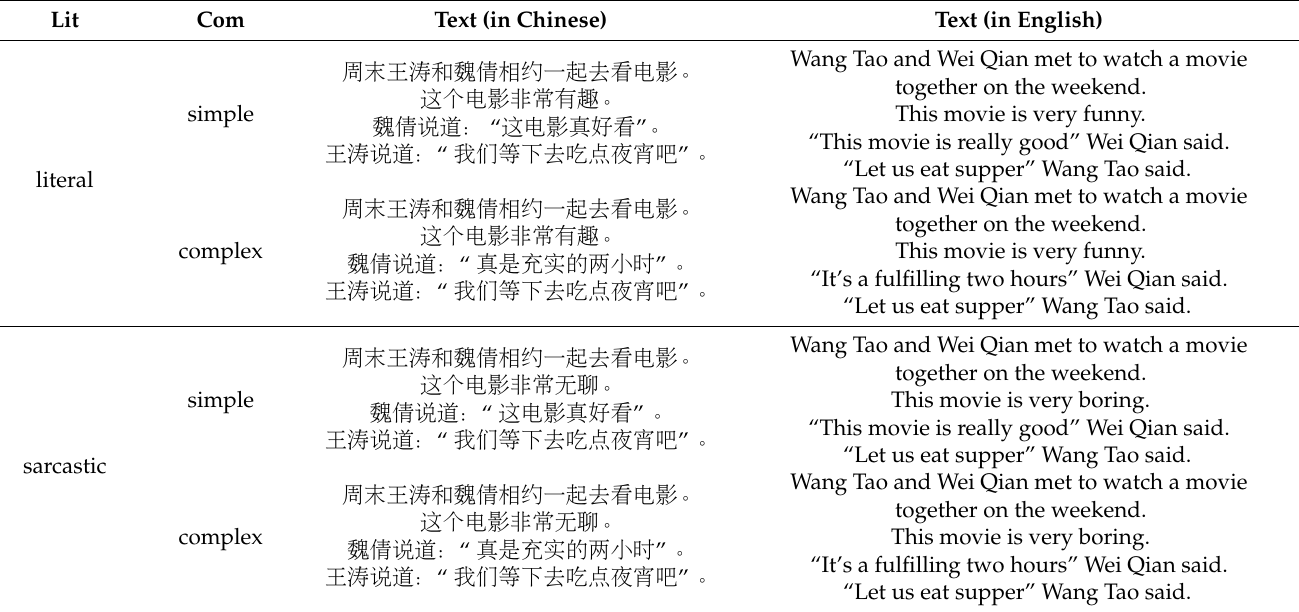
Table 1. A sample set of experimental